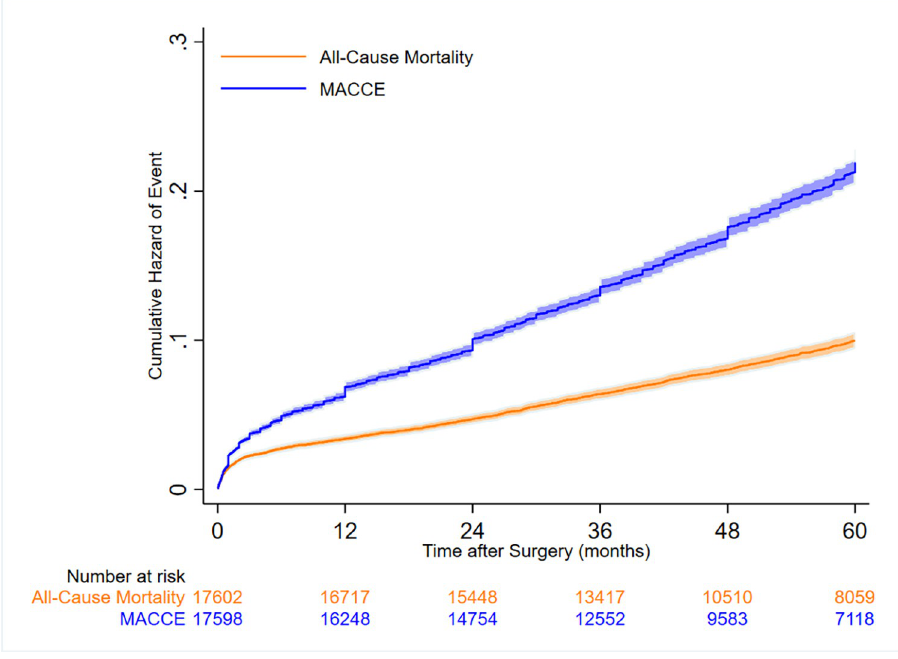
Fig 1. Unadjusted cumulative hazard of all-cause mortality and major adverse cardio-cerebrovascular events (MACCEs) after coronary artery bypass graft surgery (CABG) among all the study cohort.